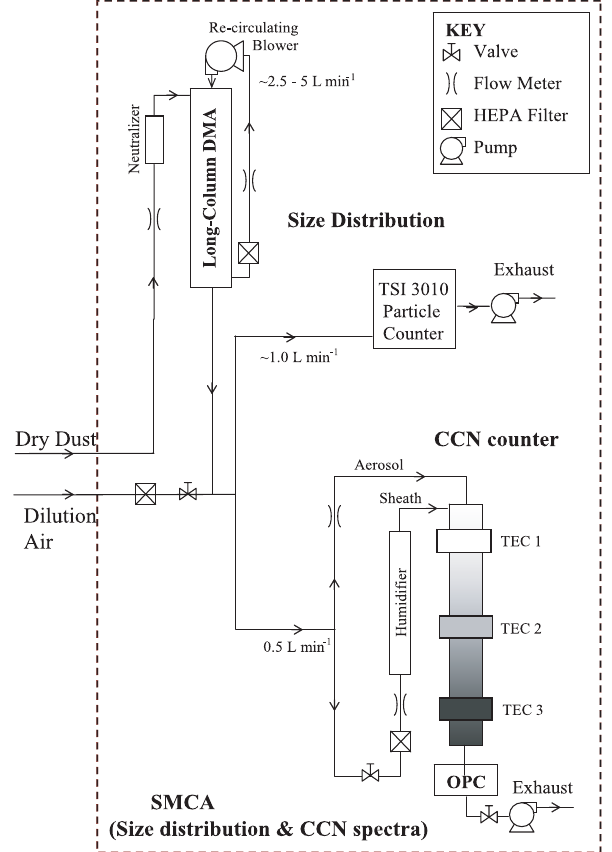
Fig. 1. Schematic of the experimental set-up used for size resolved CCN activation and droplet growth kinetics